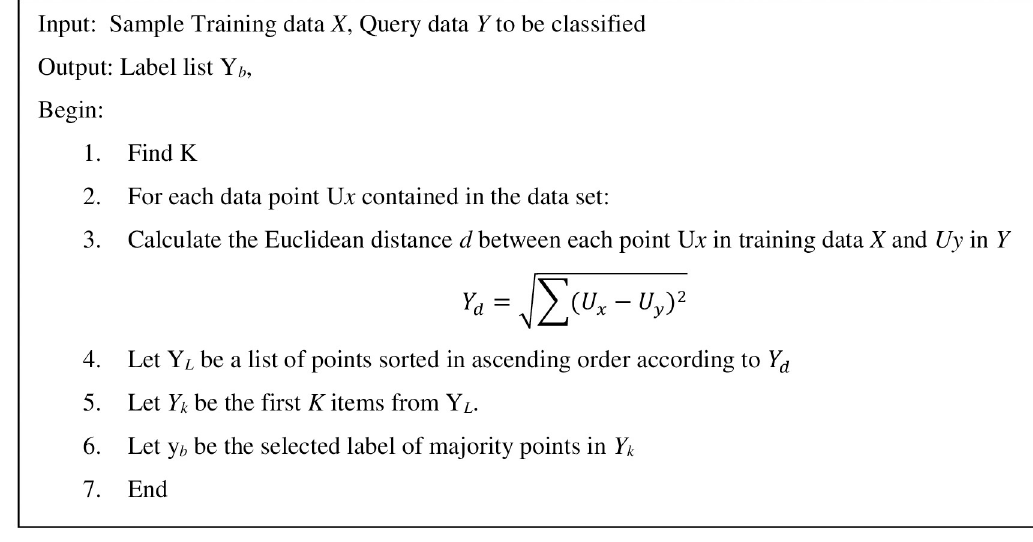
Fig 6. Classification algorithm (Algorithm